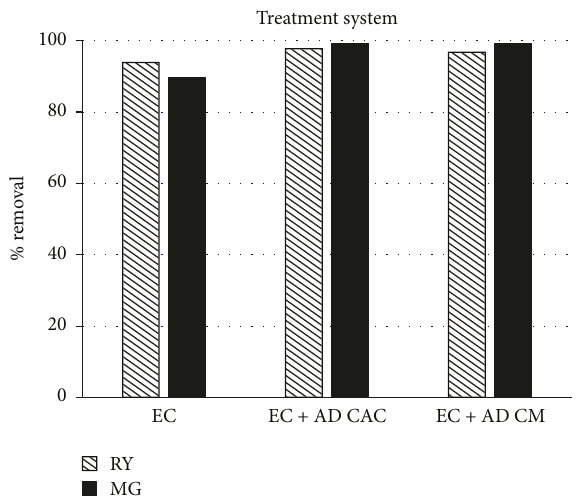
Figure 7: Malachite green and Remazol yellow removal efficiencies with electrocoagulation and electrocoagulation-adsorption CAC and electrocoagulation-adsorption